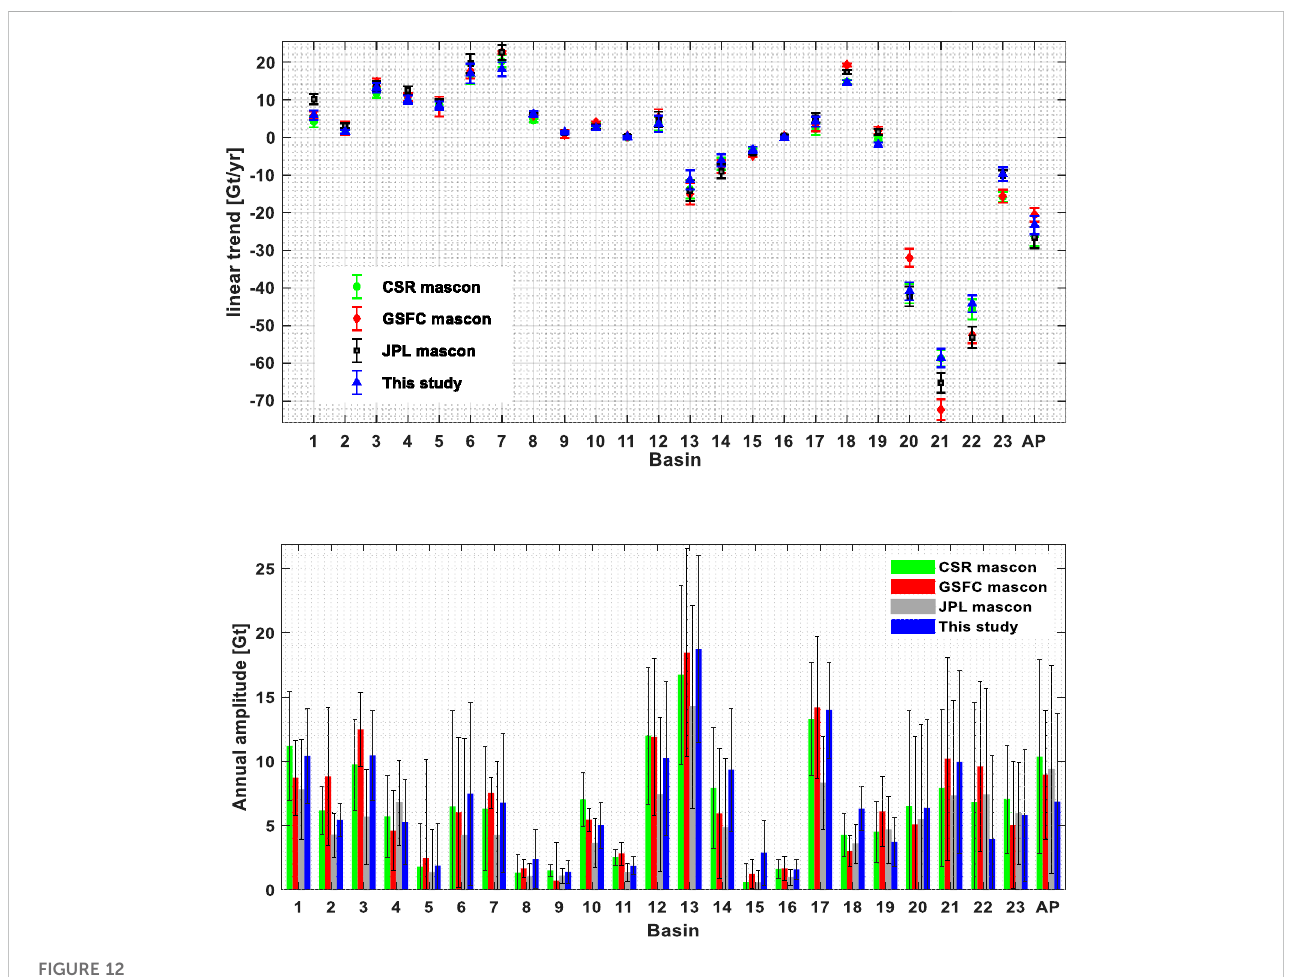
FIGURE 12 Mass change rates and annual amplitudes at a basin scale (with a 95% con fi dence level). AP denotes APIS.